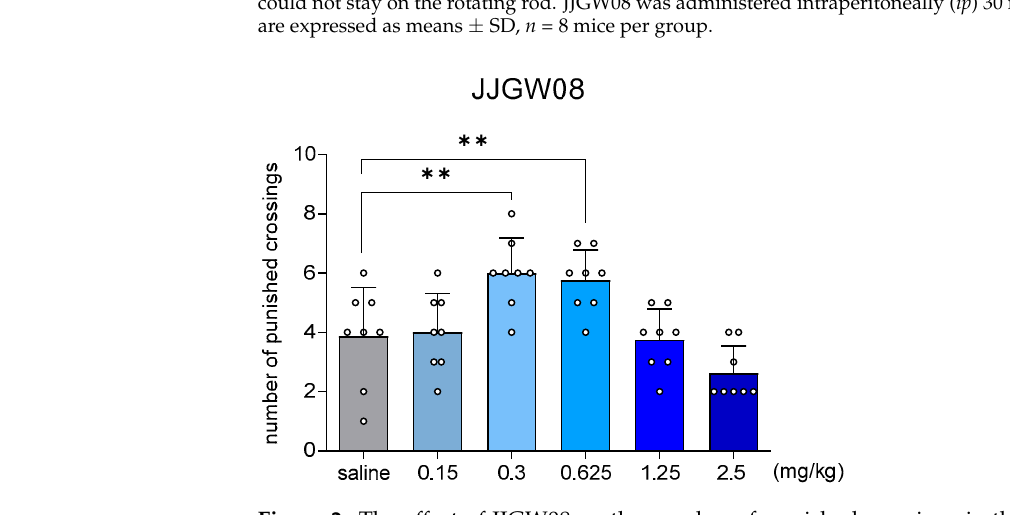
✱ ✱✱✱ Figure 3. The effect of JJGW08 and aripiprazole on the number of buried marbles by mice. Mice were placed individually in cages with a 5 cm bedding layer, where 20 glass balls were placed. The number of buried marbles after 30 min of the test was counted. JJGW08 was administered intraperitoneally ( ip ) 30 min before the test. The control group received 0.9% NaCl solution ( ip ) or 1% Tween ( ip ) for aripiprazole. Values are expressed as means ± SD in the case of one-way ANOVA (aripiprazole) or median with interquartile range in the case of Kruskal–Wallis test (JJGW08), n = 8– 10 mice per group. Statistical analysis: one-way ANOVA (Newman–Keuls post hoc ), and Kruskal– Wallis test (Dunn post hoc ), * p < 0.05, ** p < 0.01, *** p < 0.001.